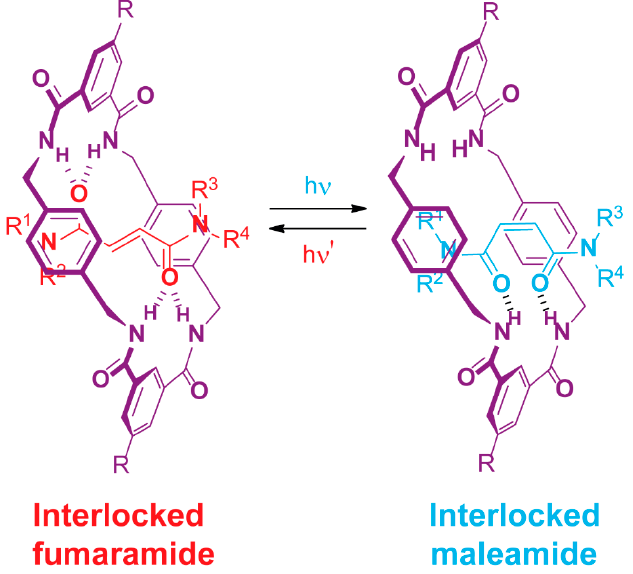
Figure 15. Reversible photoisomerization of an interlocked dicarboxamide, showing the fumaramide (in red) and maleamide (in blue) isomers.